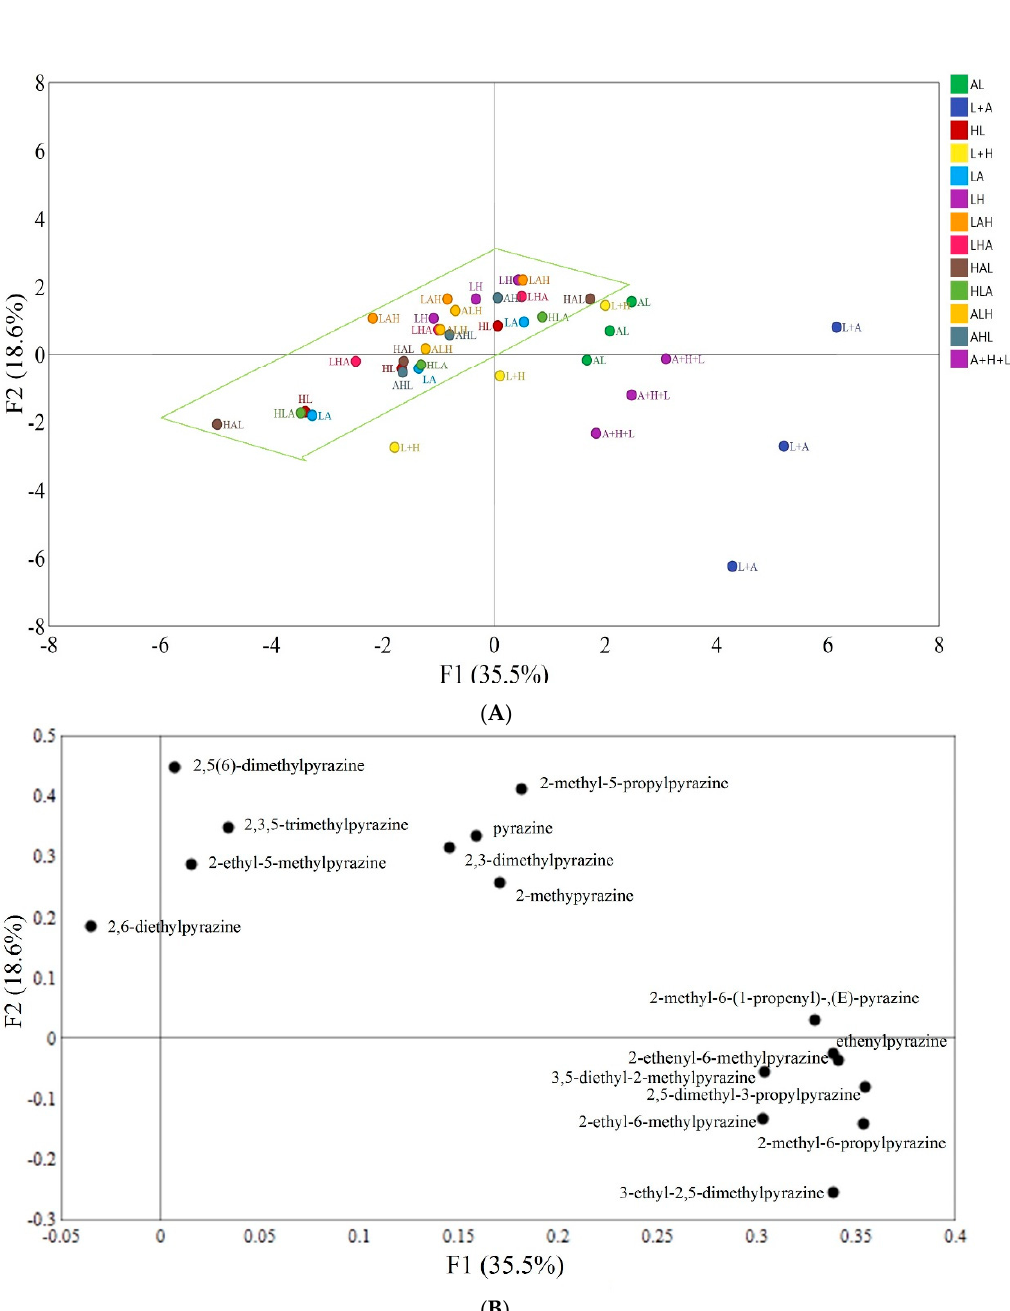
Figure 1. ( A ). The results of principal component analysis for different reaction models. AL: Arg-Lys; L + A: Control (Arg + Lys) ; HL: His-Lys; L + H: Control (His + Lys) ; LA: Lys-Arg; LH: Lys-His; LAH: Lys-Arg-His; LHA: Lys-His-Arg; HAL: His-Arg-Lys; HLA: His-Lys-Arg; ALH: Arg-Lys-His; AHL: Arg-His-Lys; A + H + L: Control (Lys + Arg + His). ( B ). Principal component analysis (PCA) of the pyrazines produced from different reaction models. Figure 1B shows the distribution of volatile components in the two principal